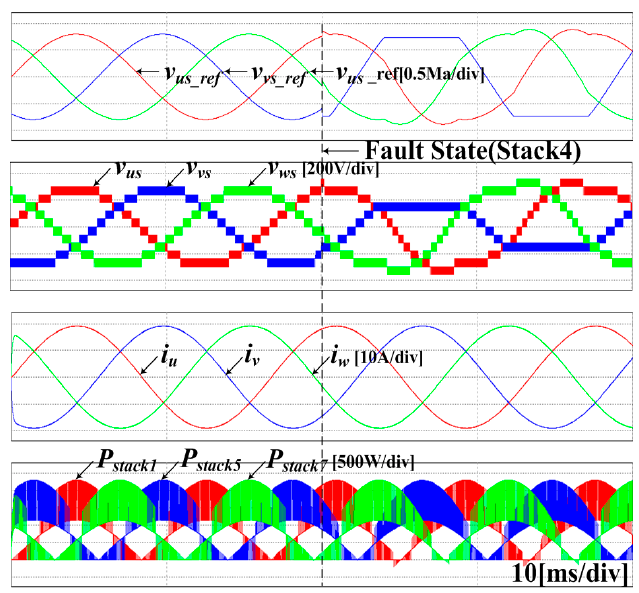
Figure 21. Simulation waveform of individual stack power when V phase fourth stack fails in applying the proposed neutral-point voltage-shifting control.